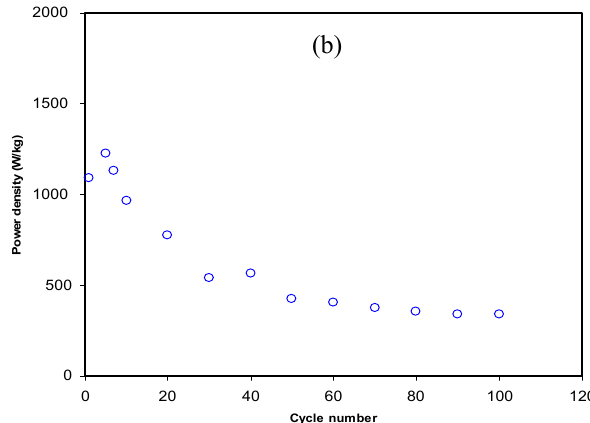
Figure 8. EDLC parameters of ( a ) energy density and ( b ) power density at 0.5 mA / cm 2 throughout the 100 cycles.